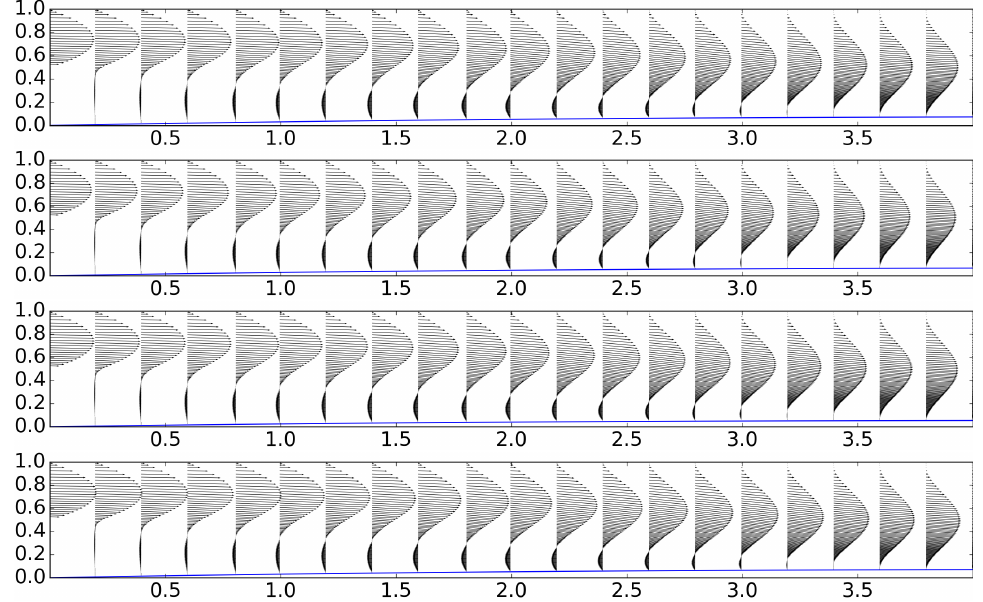
Figure 17. Computed velocity fields for t = 0, t = T /4, t = T /2, t = 3 T /4, respectively, during an inflow period T , for FSI of the flow with a membrane with T m = 55 and p e = 0.55. The inflow (Equation (1)) is oscillating with α = 0.05, and ω = 0.05. The Reynolds number is